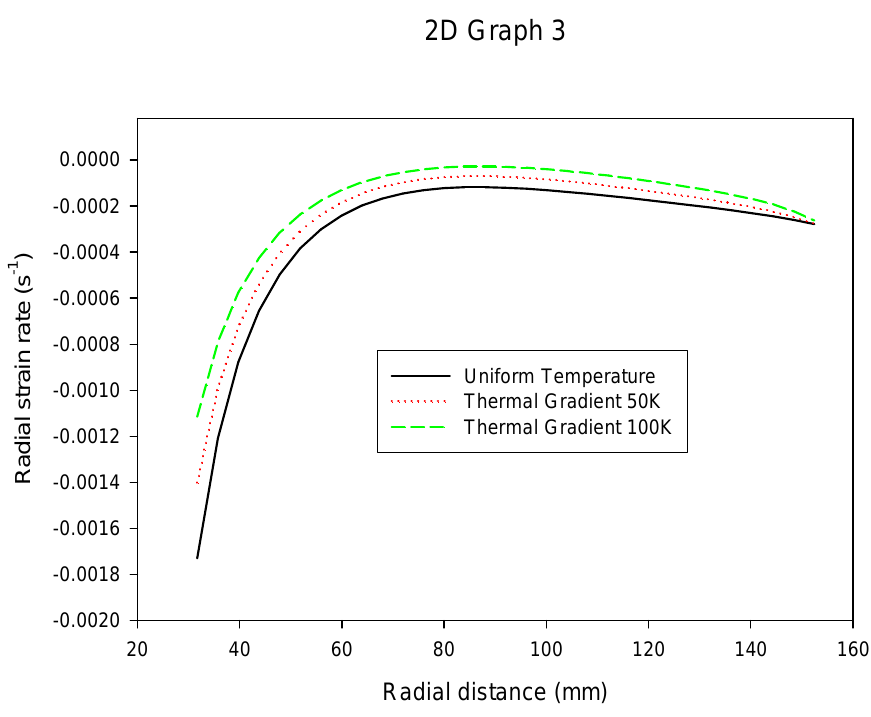
Figure 3. Variation of radial strain rate along the radial distance with composite disc with/without thermal